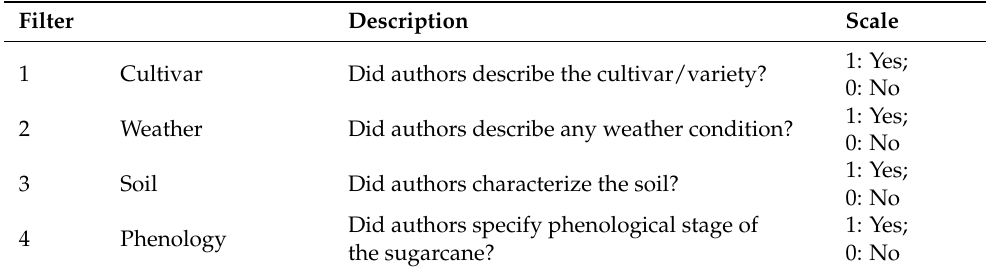
Table 2. Appraisal checklist to analyze the overall quality of research (adapted from Hanson and Jones [28] and Ogilvie et al.